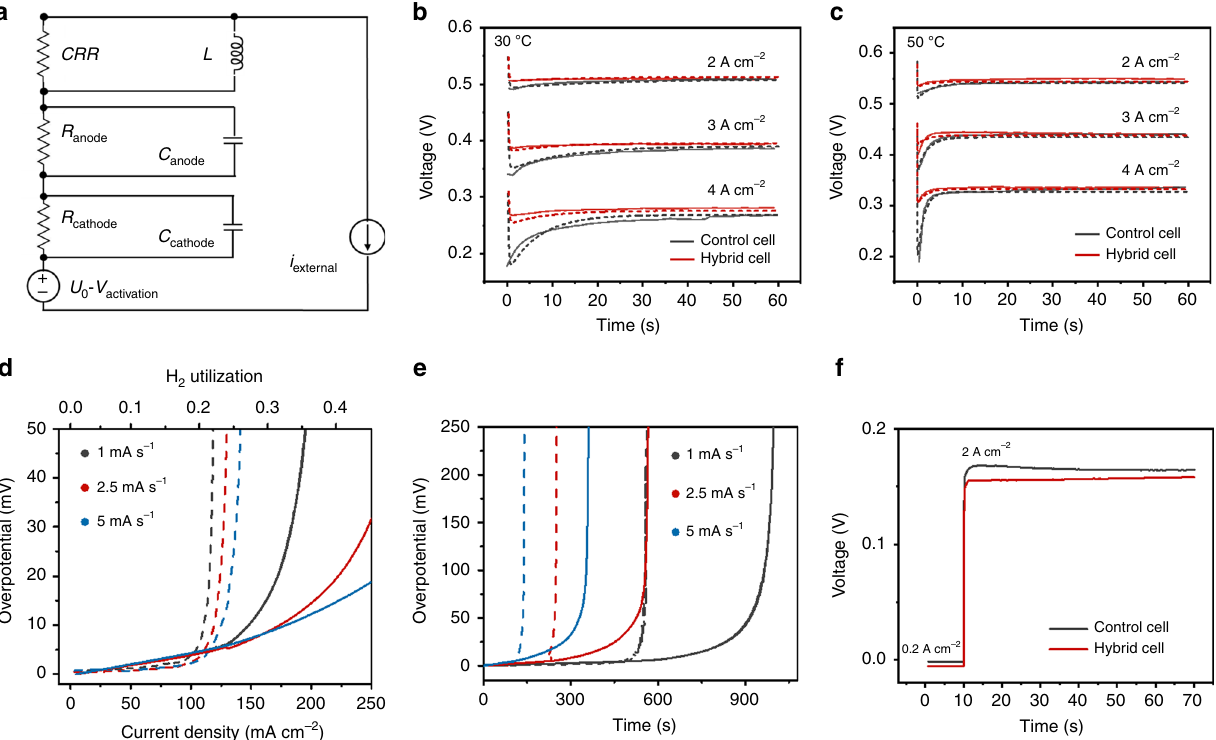
Fig. 4 Origin of the enhanced transient performance attributed by the WO 3 layer. a An equivalent circuit model for the control cell and hybrid cell. The values of CRR for the control cell (black) and hybrid cell (red) at time zero are listed in Supplementary Table 1. b , c Voltage – time pro fi les measured and fi tted pro fi les of the hybrid cell and control cell upon switching the current density from 0.2 to 2 A cm − 2 , 3, and 4 A cm − 2 at 30 °C ( b ) and 50 °C ( c ), respectively. d , e Anode overpotential of a hybrid cell (solid lines) and a control cell (dashed lines) vs. current density and H 2 utilization rate ( d ) and time ( e ) at different scan rates. 10 mL min − 1 H 2 (100% humidi fi ed) was fed to both the anodes and cathodes. f Voltage pro fi les of a hybrid cell and control cell